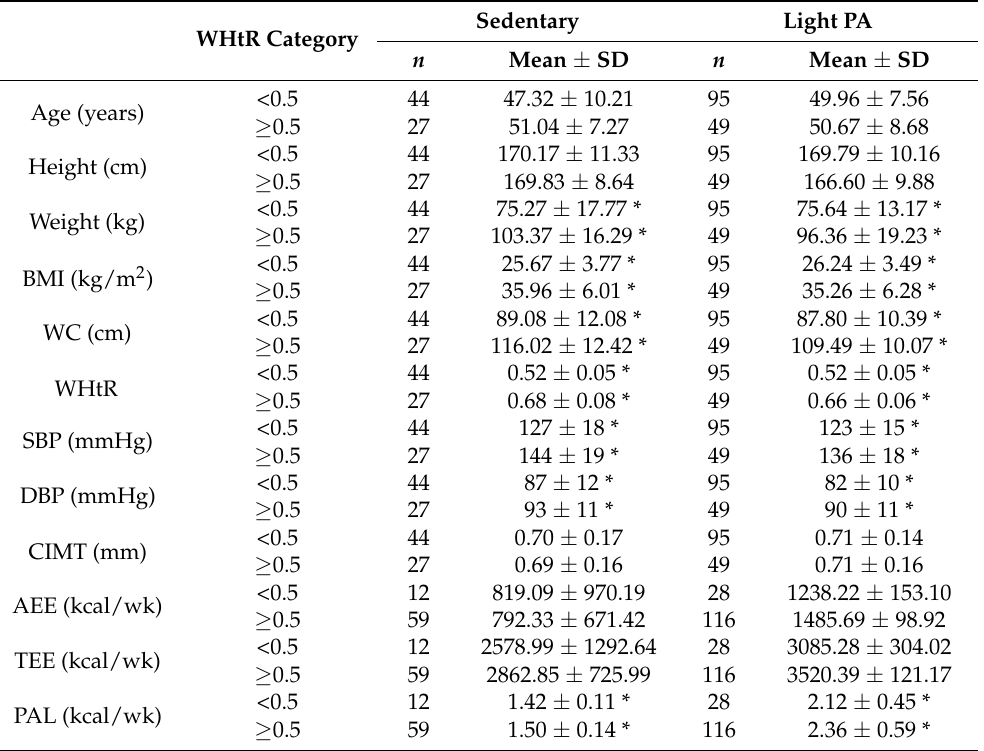
Table 3. Independent t -test for participants according to waist-to-height ratio